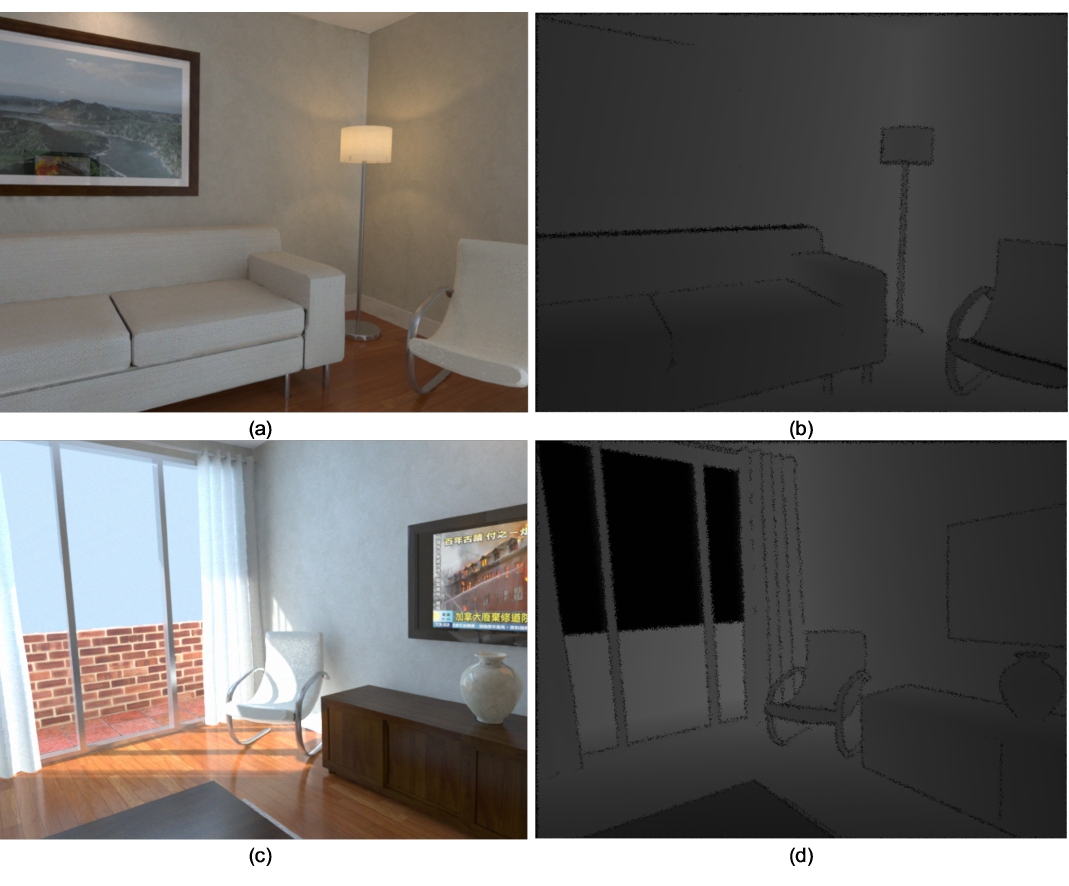
Figure 5. Sample RGB image and depth image from the dataset [44]. ( a ) and ( c ) RGB images; ( b ) and ( d ) depth